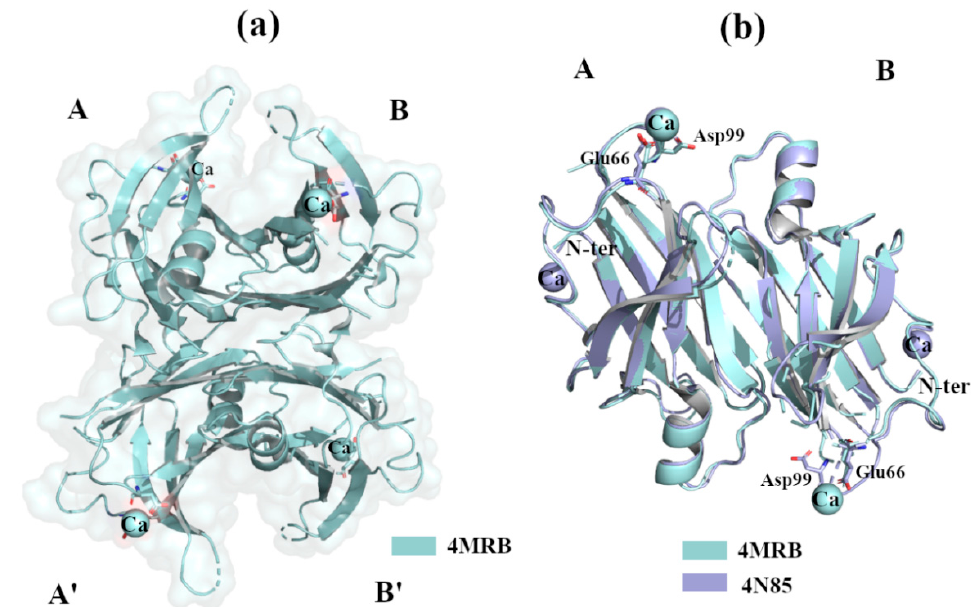
Figure 5. TTR crystal structures in complex with Ca 2+ . The figure was created by author downloading the appropriate PDB codes. ( a ) Tetramer representation of TTR in complex with Ca 2+ . ( b ) Superposition of the two dimers A-B of TTR in complex with Ca 2+ . Recently, studies in solution show that Ca 2+ does not modify the environment around tryptophan residues, confirming that it does not induce global structural changes [63].